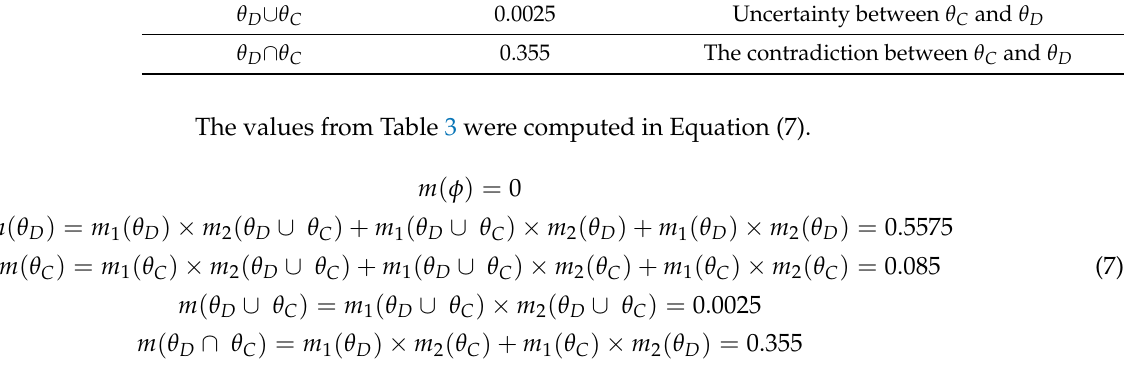
The contradiction between θ C and θ